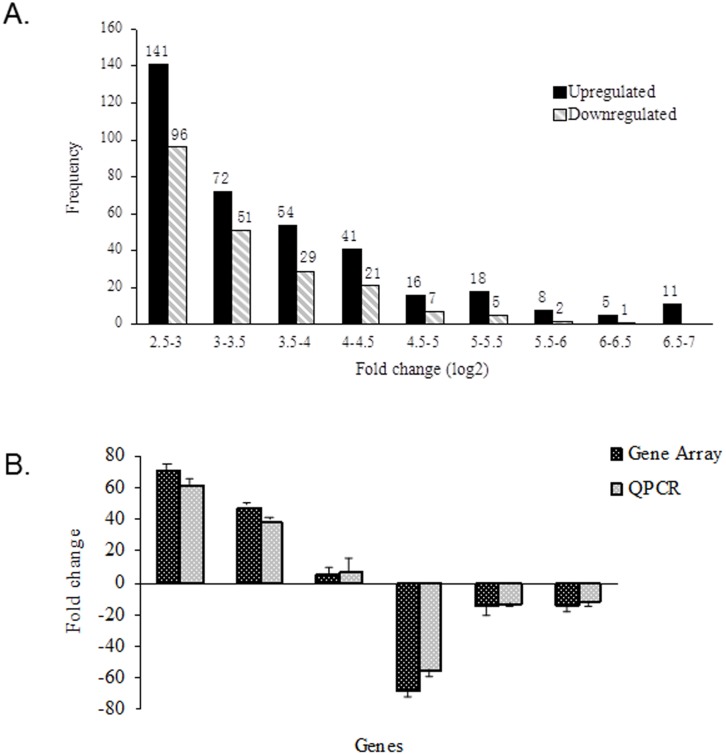
Gene expression profiling of leukemic cells sensitive or resistant to Ara-C.Fig. 5A) Histogram plot shows the distribution of genes with a fold change (log2) over 2.5. Fold changes were calculated by Rosetta Resolver 7.2 with error model adjusted by Amersham Pairwise Ration Builder for signal comparison of samples. Fig. 5B) Validation of the differences in expression of Dnmt3L, Plau, Bcl-2, CD72, Uba7 and Pdrg1 genes by quantitative PCR. In order to verify the direction and magnitude of the changes in gene expression induced by resistance of Ara-C in the gene microarrays, q-PCR was performed using primers to the selected genes whose expression levels were significantly altered in the array analysis.